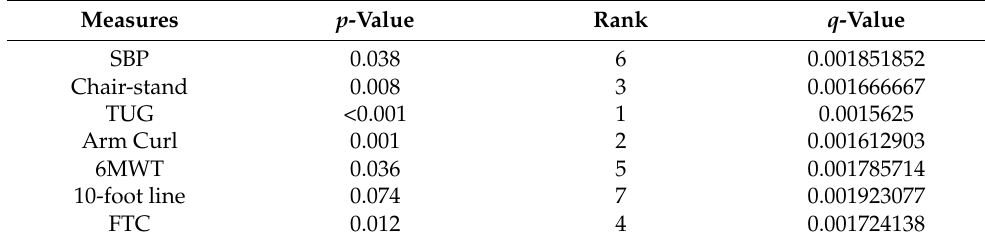
Table A2. Benjamini-Hochberg false rate discovery procedure for regression